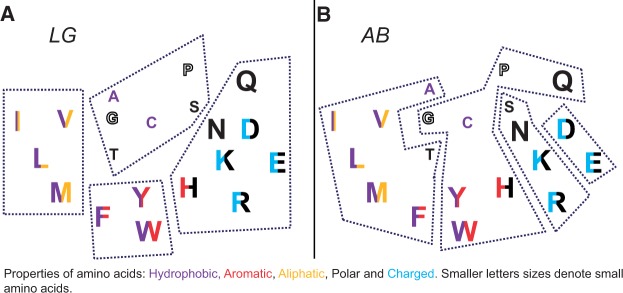
The modularity maximization analysis showing the inferred optimal clusters of most frequently exchanged amino acids: (A) For LG with modularity M = 0.38 and (B) for AB with modularity M = 0.24. The significantly higher modularity for LG shows the clearer structure of the LG model, with a tendency to conserve amino acid properties. Colors and letter size reflect the physicochemical properties of amino acids as suggested by Taylor (1986) and revised by Betts and Russell (2007).